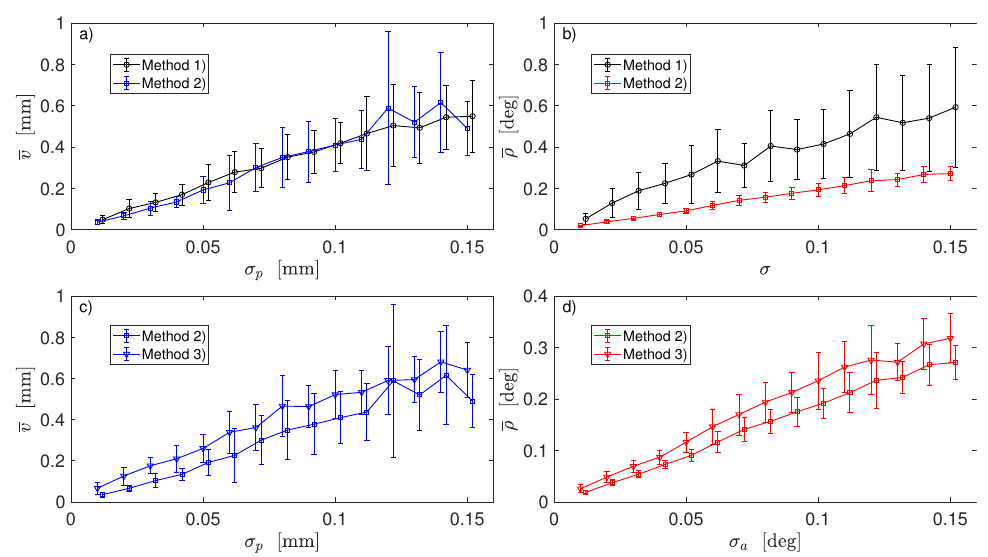
Figure 5. Comparison of three calibration methods: ( a ) dependence of the mean positional error v of robot end-effector on positional noise σ p —Registration 1 was used in Method 2 (blue line); ( b ) dependence of the mean orientation error ρ of robot end-effector on noise ( σ = σ p for Method 1 and σ = σ a for Method 2)—Registration 2 was used in Method 2 (red line); ( c ) dependence of error v on positional noise σ p —Registration 1 was used in both methods; ( d ) dependence of error ρ on noise σ a —Registration 2 was used in both methods.